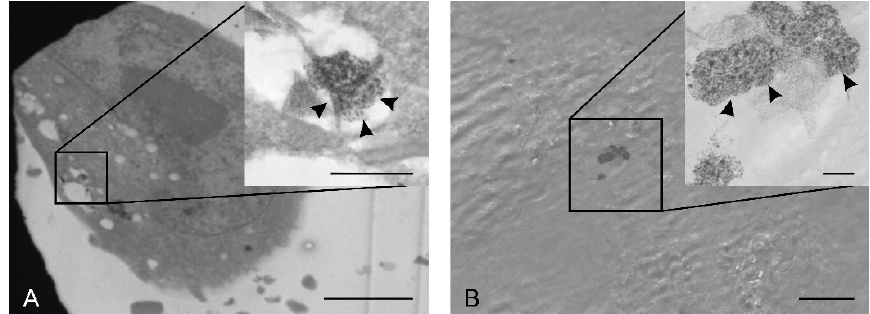
Figure 10. TEM micrographs showing the presence of electron-dense structures (black arrow heads) inside A375 cells ( A , bar at 5 µm, with inset with bar at 500 nm) and HaCaT cells ( B , bar at 2 µm, with inset with bar at 200 nm).